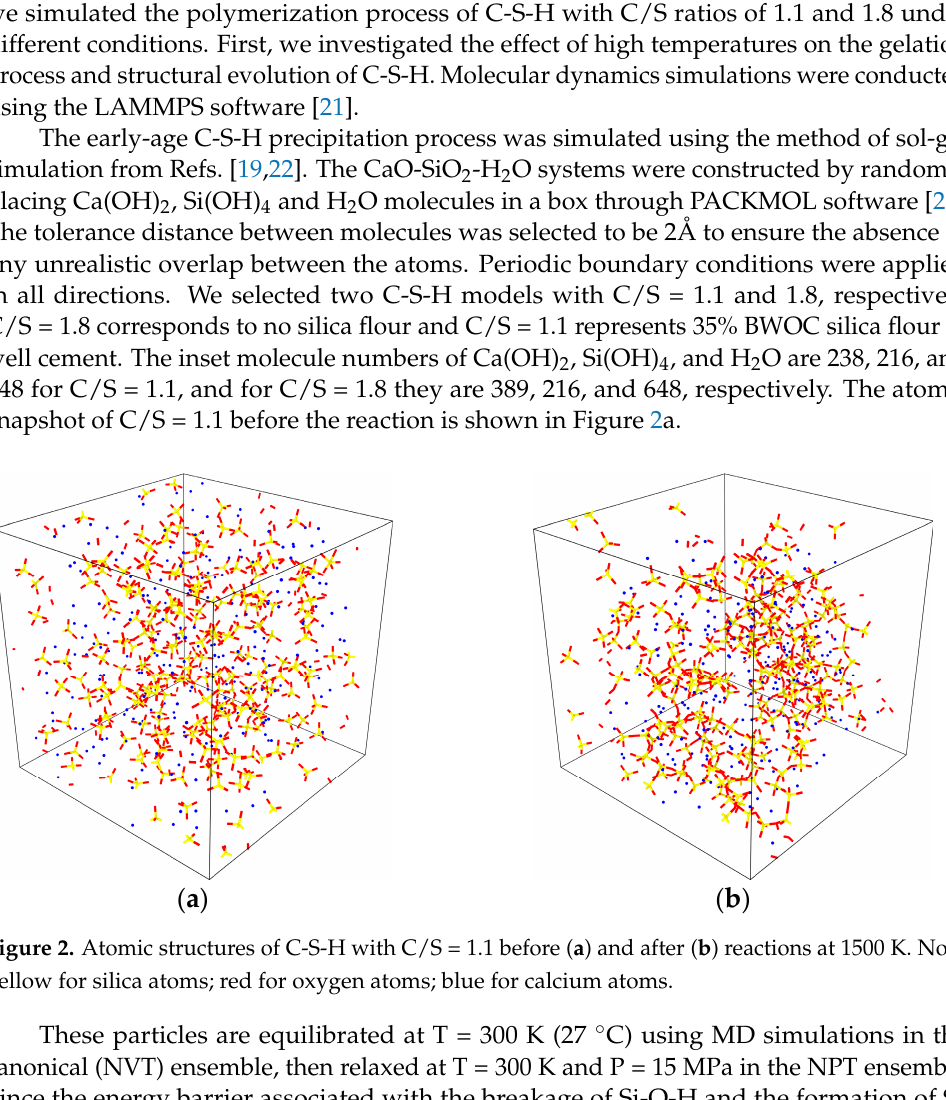
Figure 1. Testing and specimens. ( a ) Triaxial compression tests and specimens. ( b ) Brazilian split- ting tensile strength tests and specimens.